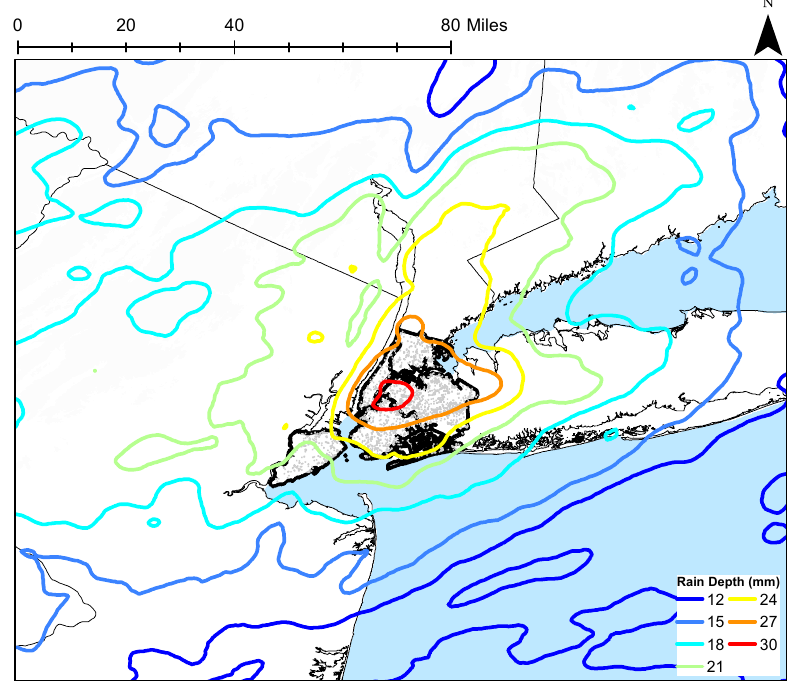
Figure 9. Daily-averaged rainfall for days of known flooding. Grey points represent locations of 311 flood reports on these days. Bold black lines represent NYC borough boundaries, white areas represent land masses, and blue areas represent water